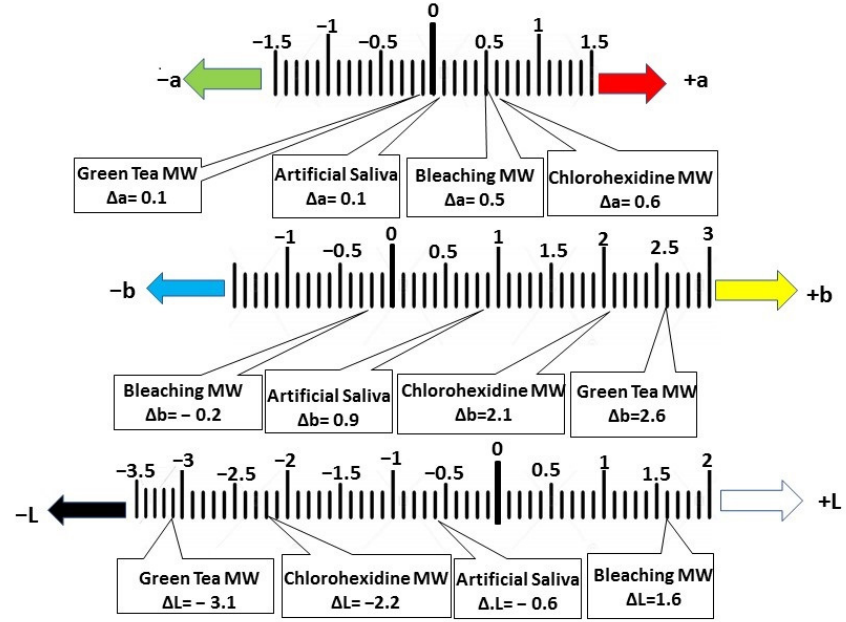
Figure 2. Color changes in resin composite after immersion in artificial saliva and various mouth- washes across red–green axis ( ∆ a), yellow–blue axis ( ∆ b), and lightness ( ∆